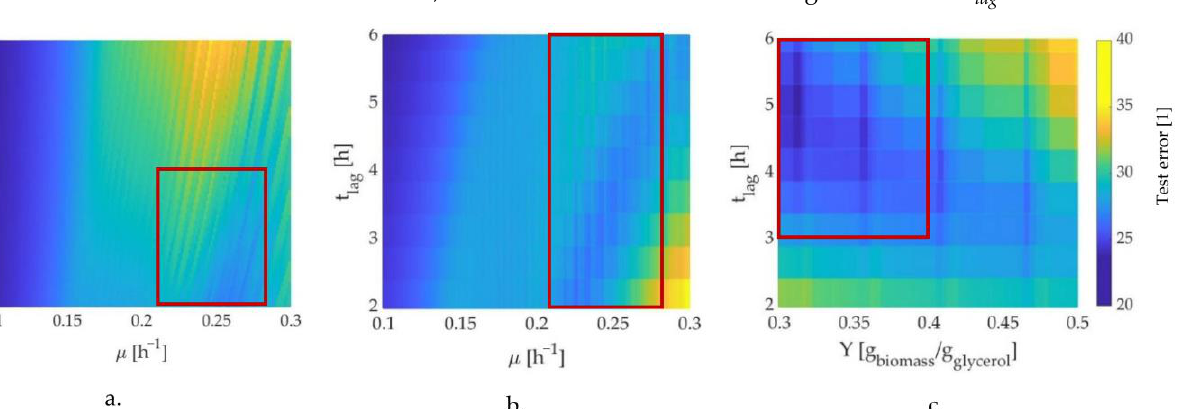
Table 2. Optimized process model parameters obtained in different approaches.